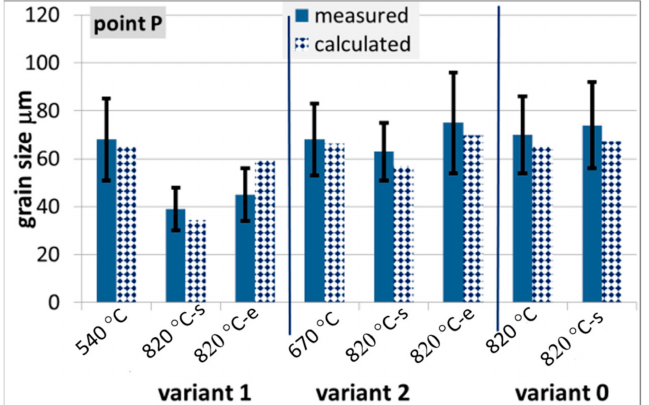
Figure 14. Measured and calculated austenite grain size at various stages of the process for steel C.